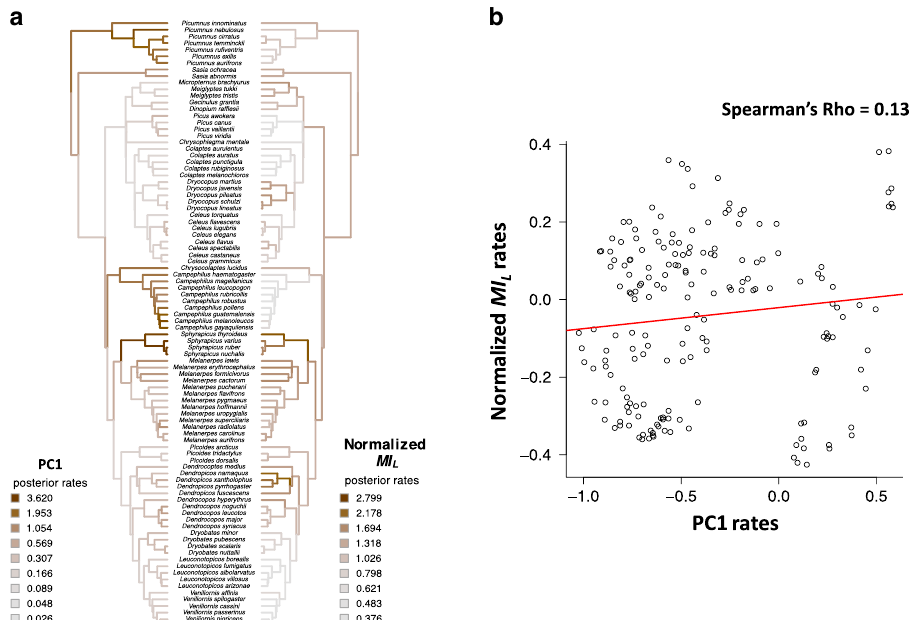
Fig. 4 Evolutionary changes of drumming structure and species-speci fi c information. a Reconstruction of the evolutionary rates for drumming acoustic structure ( ‘ PC1 ’ ) and normalized MI L along the woodpeckers ’ phylogeny ( n = 92 species). Both trees are based on relaxed-rates Brownian motion evolutionary models. Average posterior rates have been standardized (dividing variables by their respective standard deviation before model computation) and are represented by a colour-gradient (scales indicated in the Figure). These gradients do not indicate an increase or decrease of the absolute trait values, but rather whether the rate of change (i.e. the diversi fi cation speed) of a trait increases or decreases. b Correlations between evolutionary rates of acoustic structure (represented by PC1) and MI L . Rates were log-transformed; for acoustic structure represented by PC2-PC6, see Supplementary Fig 10. Source data are provided as a Source data fi